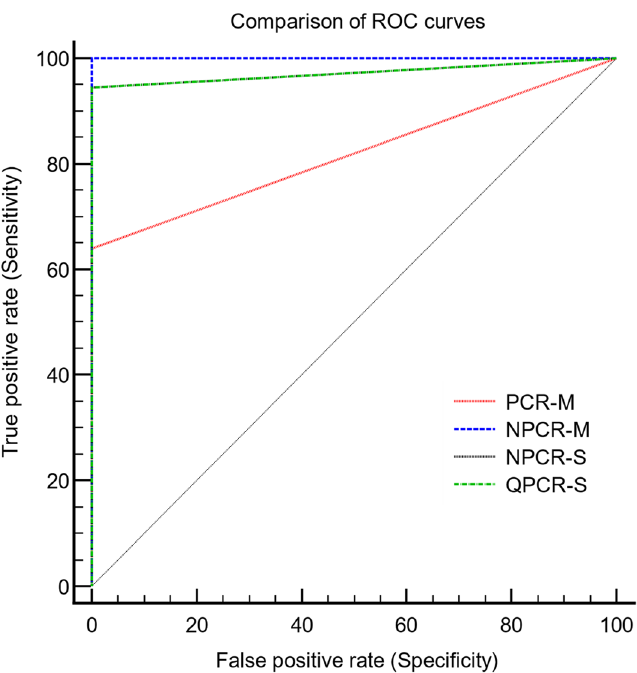
Figure 1. Comparison of receiver operating characteristic (ROC) curves of various PCRs analyzed in this study. Single-round PCR-M = reverse transcription (RT) polymerase chain reaction (PCR) targeting the M segment of the SFTS virus. NPCR-M = RT-nested PCR targeting the M-segment of the SFTS virus. NPCR-S = RT-nested PCR targeting the S-segment of the SFTS virus. QPCR-S = Real-time RT PCR targeting the S-segment of the SFTS